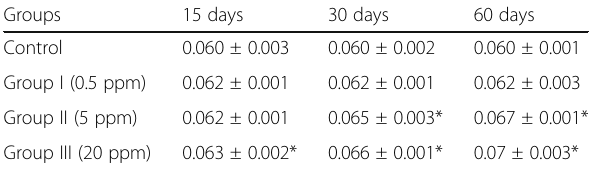
Table 3 Serum fluoride levels in rats after 15, 30, and 60 days